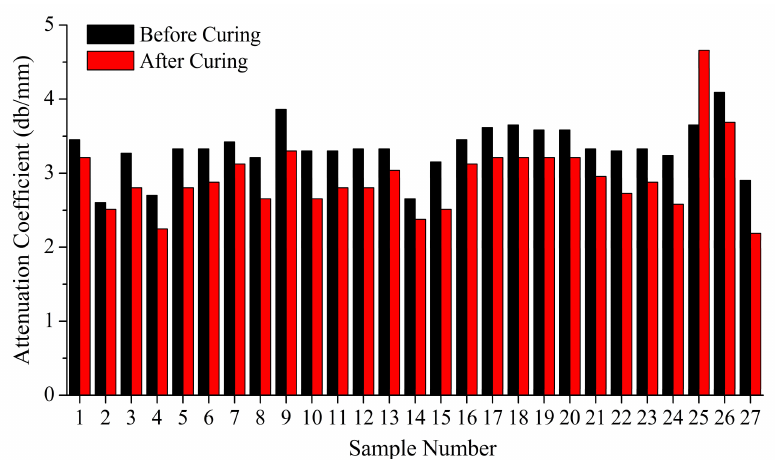
Figure 9. The average attenuation rates before and after curing.